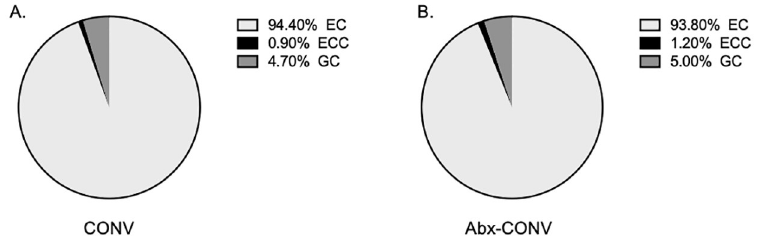
Fig 6. Cellular composition of intestinal epithelium in vehicle and Abx-CONV mice. The proportion of villus epithelial cells (% cell type / total nucleated cells) is similar between (A) Vehicle and (B) Abx-CONV. EC (Enterocyte), ECC (Enterochromaffin Cell), GC (Goblet Cell). n = 3 CONV mice, n = 3 Abx-CONV mice.